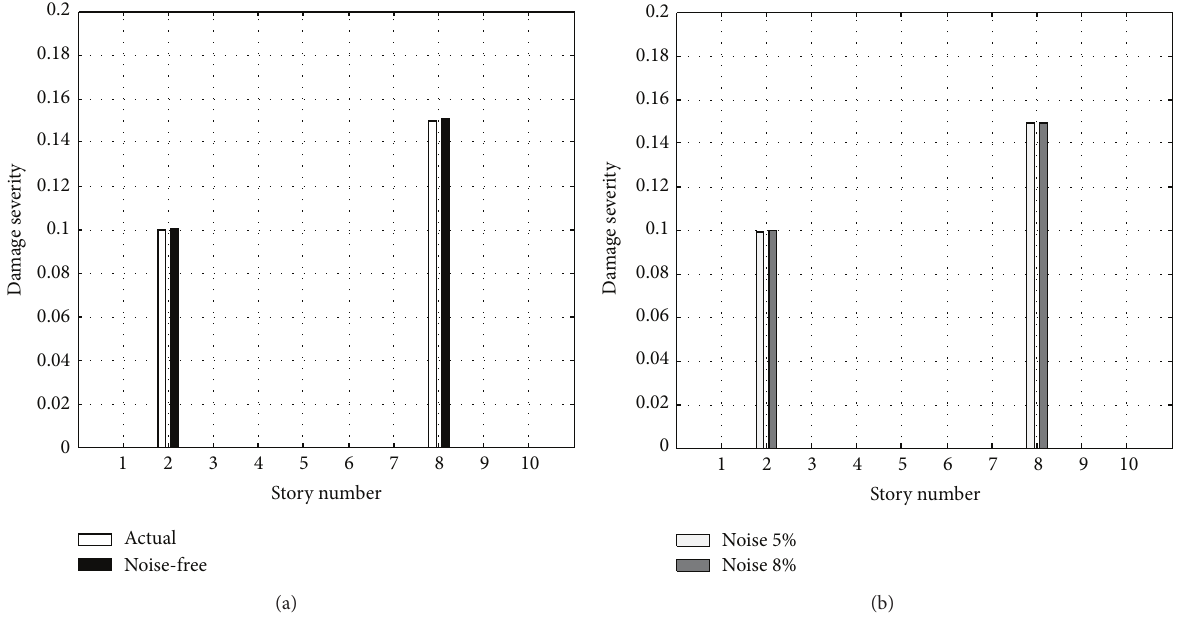
Figure 10: Damage detection results in the ten-story shear frame for scenario II.